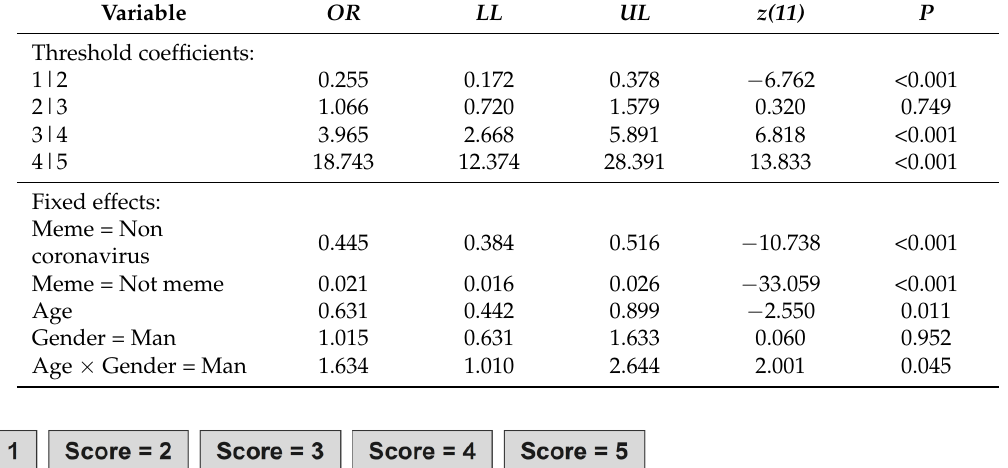
Table 6. Results of the cumulative link mixed model comparing funniness of coronavirus memes with non-coronavirus memes and sample of images (not a meme). The threshold coefficients show the transition chances in the questionnaire score point to the next. The model included effects of age, sex, and interaction between age and sex. Random factors were questionnaire identity and participants identity (nested in questionnaire identity). Odds ratio (OR) with 95% confidence intervals (LL–lower confidence intervals, UL–upper confidence intervals) and Wald z–test (with effective degrees of freedom). Model explained 17% variation in data (McFadden pseudo- R 2 ).